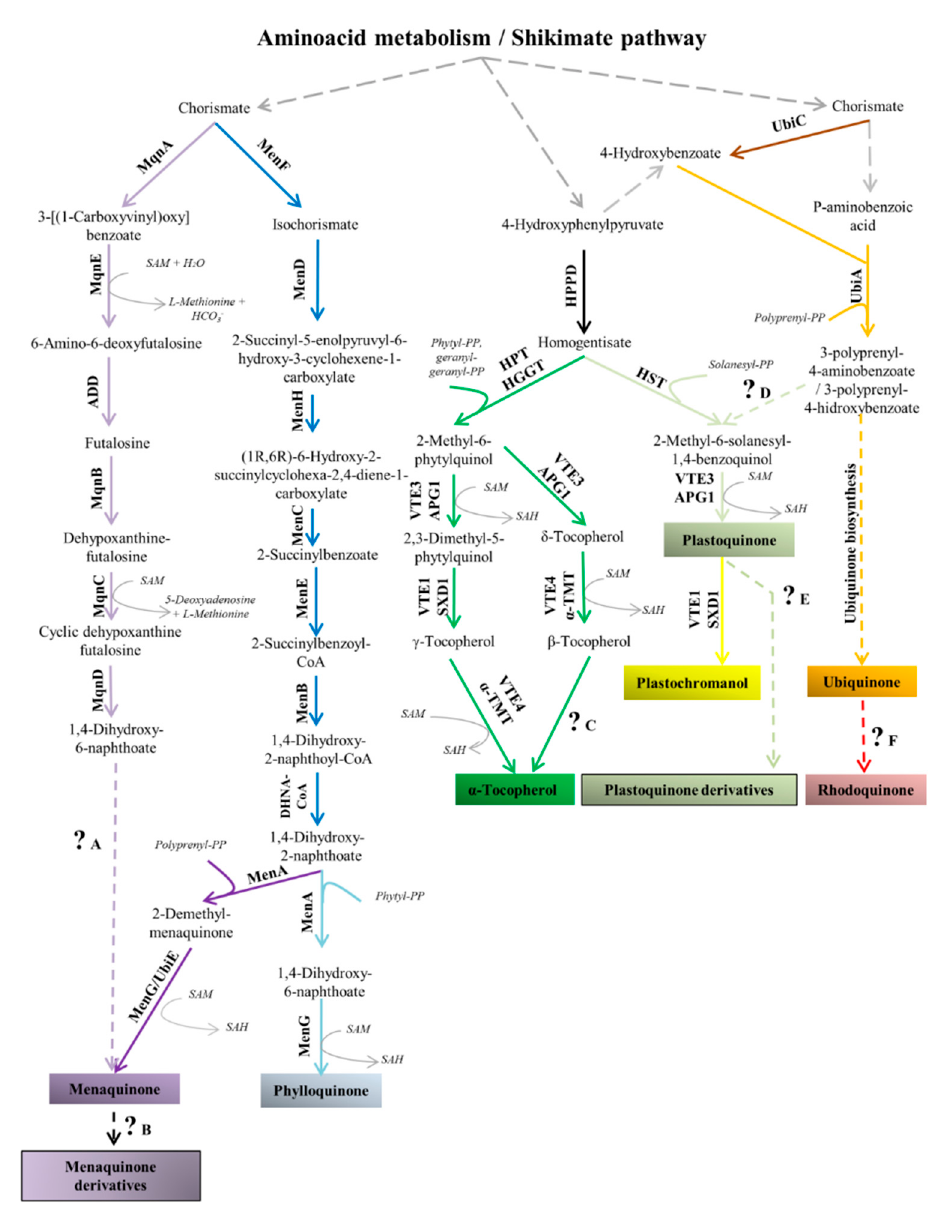
Figure 5. Prenylquinone biosynthesis pathways [45]. Some prenylquinones shown have not been found in pathogenic protozoa, but all are cited in this review. The specific pathway of ubiquinone biosynthesis (orange arrows) and the formation of aromatic precursors from amino acid metabolism / shikimate pathways (gray arrows) are simplified because these processes are better described in other figures in this review. The incorporation of isoprene chains and use of S-adenosyl-L-methionine (SAM) by enzymes are indicated. The SAM cofactor is necessary for methylation reactions to produce S-adenosyl homocysteine or for other biochemical processes. Continuous arrows indicate a single enzymatic step, and discontinuous arrows indicate several enzymatic steps, processes that remain poorly understood or processes that are better shown in other figures in this review. The di ff erent pathways are distinguishable by the colors of the arrows: Light purple. MQ biosynthesis by the futalosine alternative pathway; Dark blue. Homologous enzymatic steps that are common for PK or MQ biosynthesis by the classic pathway; Dark purple. Specific enzymatic steps for MQ biosynthesis by the classic pathway; Light blue. Enzymatic steps that are specific for PK biosynthesis; Black. Biosynthesis of homogentisate from 4-hydroxyphenylpyruvate; Dark green. Tocopherol biosynthesis [142]; Light green. Shared enzymatic steps for PQ and plastochromanol biosynthesis; Yellow. Plastochromanol biosynthesis [45]; Brown. 4-Hydroxybenzoate biosynthesis from chorismate; Orange. Ubiquinone biosynthesis; Red. Possible rhodoquinone biosynthesis pathway in Rhodospirillum rubrum [143]. The figure also indicates processes that remain poorly understood. ?A. The final steps of the futalosine alternative pathway